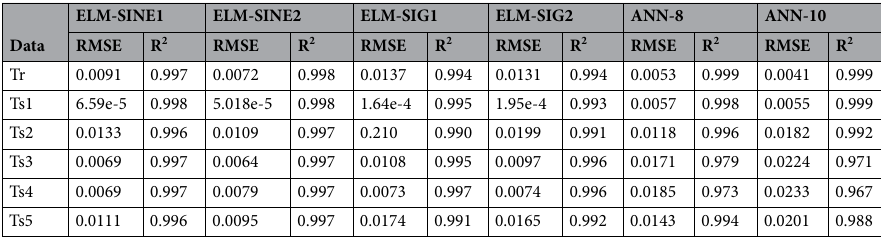
Table 6. The accuracy of various configurations for the proposed models. Significant values are in